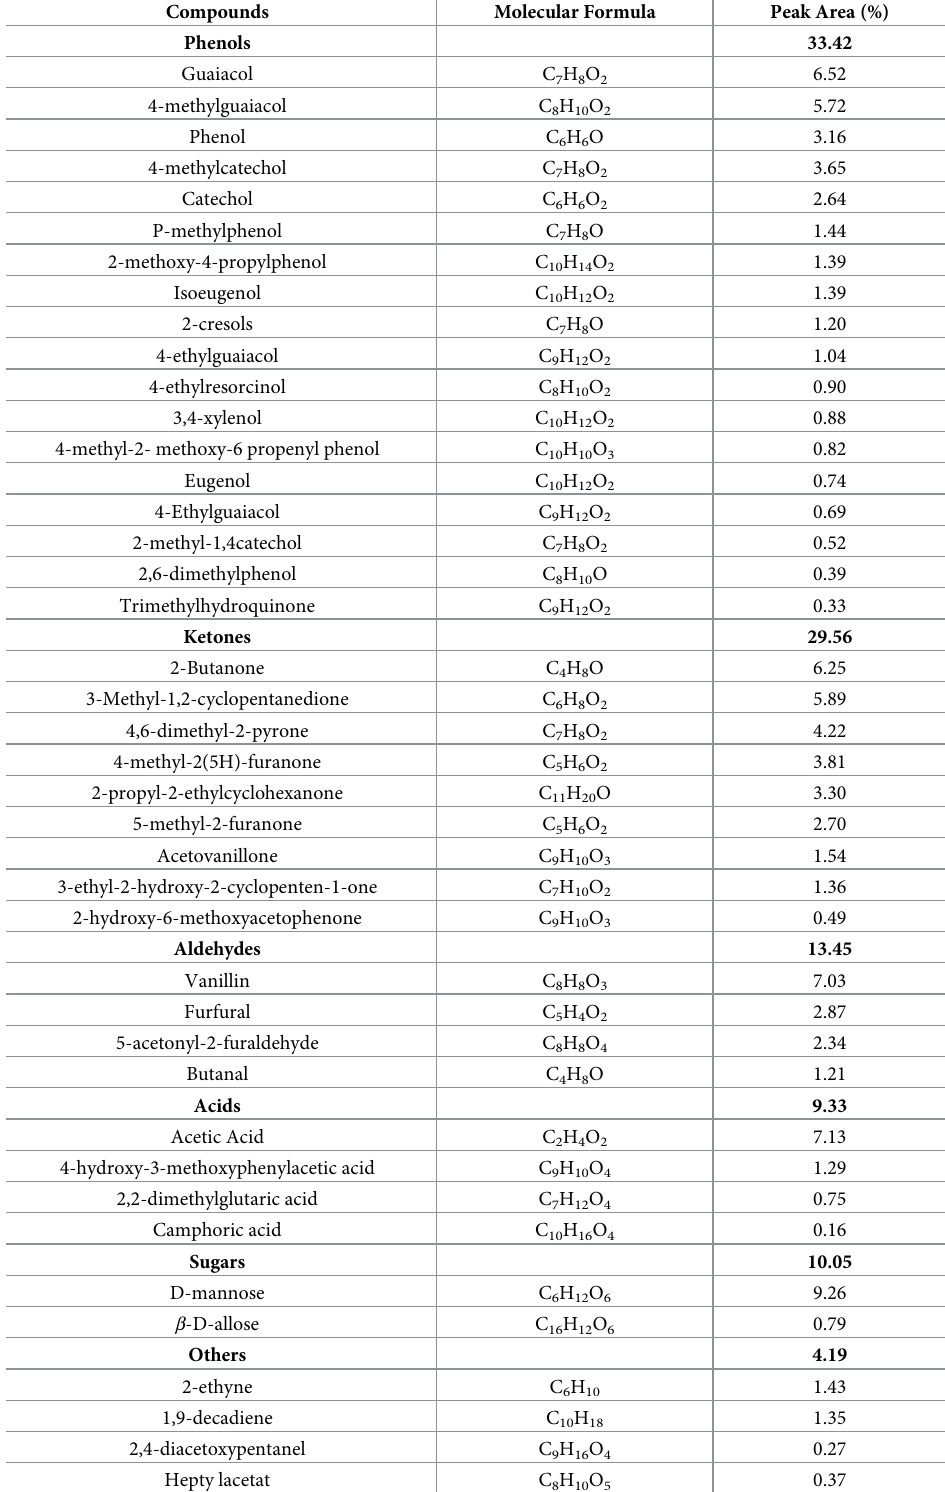
Table 1. GC-MS of